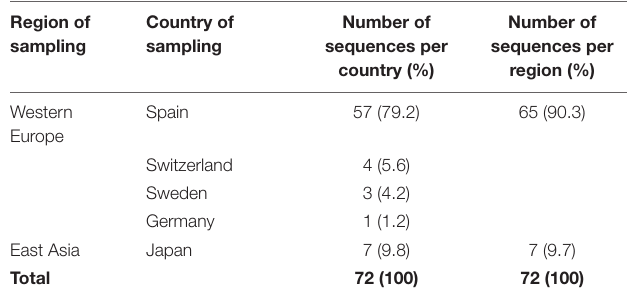
TABLE 3 | Sampling region/country for sequences with known date of sampling found within the largest CRF02_AG monophyletic cluster (subepidemic) in